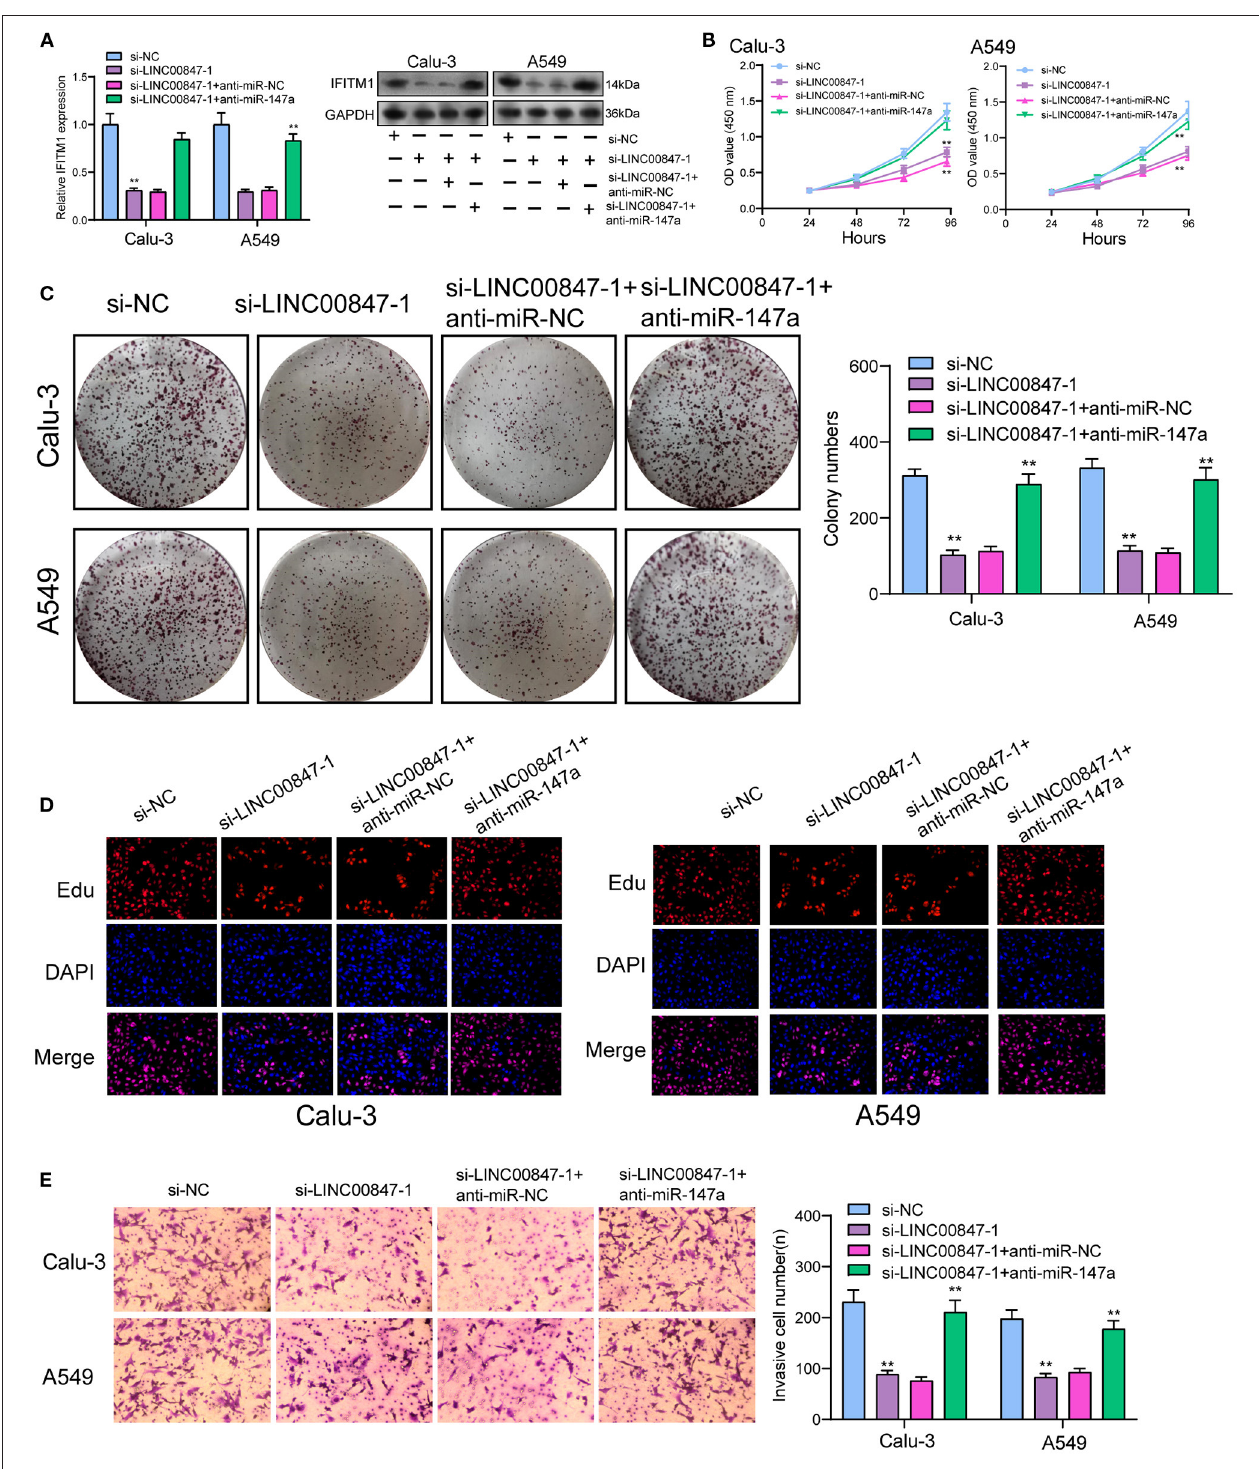
FIGURE 7 | LINC00847 promoted the progression of NSCLC via sponging miR-146a to increase IFITM1. (A) The expression of IFITM1 at mRNA and protein level in Calu-3 and A549 cells after transfected with si-LINC00847-1, si-LINC00847-1/anti-miR-NC or si-LINC00847-1/anti-miR-147a. (B) CCK-8, (C) colon formation and (D) EdU were performed to detect cell proliferation. (E) The cell invasive ability of Calu-3 and A549 cells were assessed using Trans well-assays. ** p < 0.01.